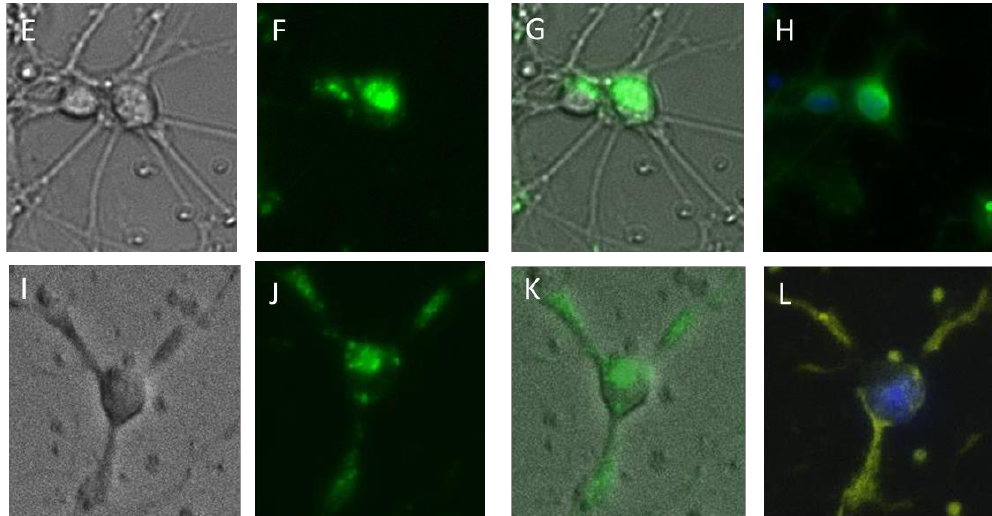
Figure 8. Microphotos of primary cell culture of the mouse mesencephalon ( A – D ) and metencephalon ( E – L ) (7th day of cultivation) after the following procedures: (i) phase contrast photography ( A , E , I ); (ii) incubation with 50 nM GBR-BP and photography of GBR-BP-stained fluorescent cells ( B , F , J ); (iii) merging the images obtained in “i” and “ii” ( C , G , K ); (iv) fixation with 4% paraformaldehyde with loss of GBR-BP fluorescence followed by fluorescent immunostaining of mesencephalic cells for tyrosine hydroxylase ((TH); dilution 1:500) (Abcam, ab19353) ( D ) and metencephalic cells for dopamine- β -hydroxylase ((DBH); dilution 1:500) (Chemicon, ab1542)) ( H ) or 5-hydroxytryptamine (5-HT; dilution 1:750) (Sigma, S5575) ( L ) and DAPi staining of neuronal nuclei. Objective × 20 (Plan-Neufluar). Bar = 50 µm.